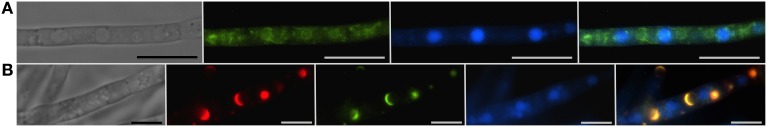
Vacuoles, the ER and toxisomes in F. graminearum. Organelles are visualized in a strain of F. graminearum having a GFP-tagged HMG CoA reductase and a TagRFP-T-tagged trichodiene oxygenase. (A) Strain grown in minimal medium which does not induce trichothecene synthesis. (Left to right) Hypha visualized using differential interference contrast (DIC) microscopy; GFP fluorescence showing HMG CoA reductase consistent with localization to reticulate and perinuclear ER; CMAC fluorescence used to visualize vacuoles; combined GFP and CMAC fluorescence showing both ER and vacuoles. Bar = 10 μm. (B) Strain grown in medium which induces trichothecene synthesis. (Left to right) Hypha visualized using DIC; TagRFP-T florescence showing trichodiene oxygenase within the membrane of spherical toxisomes; GFP fluorescence showing HMG CoA reductase within the membrane of spherical toxisomes; CMAC fluorescence used to visualize vacuoles; combined GFP, RS-Red and CMAC fluorescence showing co-localization of HMG CoA reductase and trichodiene oxygenase in toxisomes and vacuoles. Bar = 5 μm. (Note that the TagRFP-T tagged trichodiene oxygenase is expressed only under toxin inducing conditions). Results presented in Menke et al. (2013); figure generated for Weber (2013).